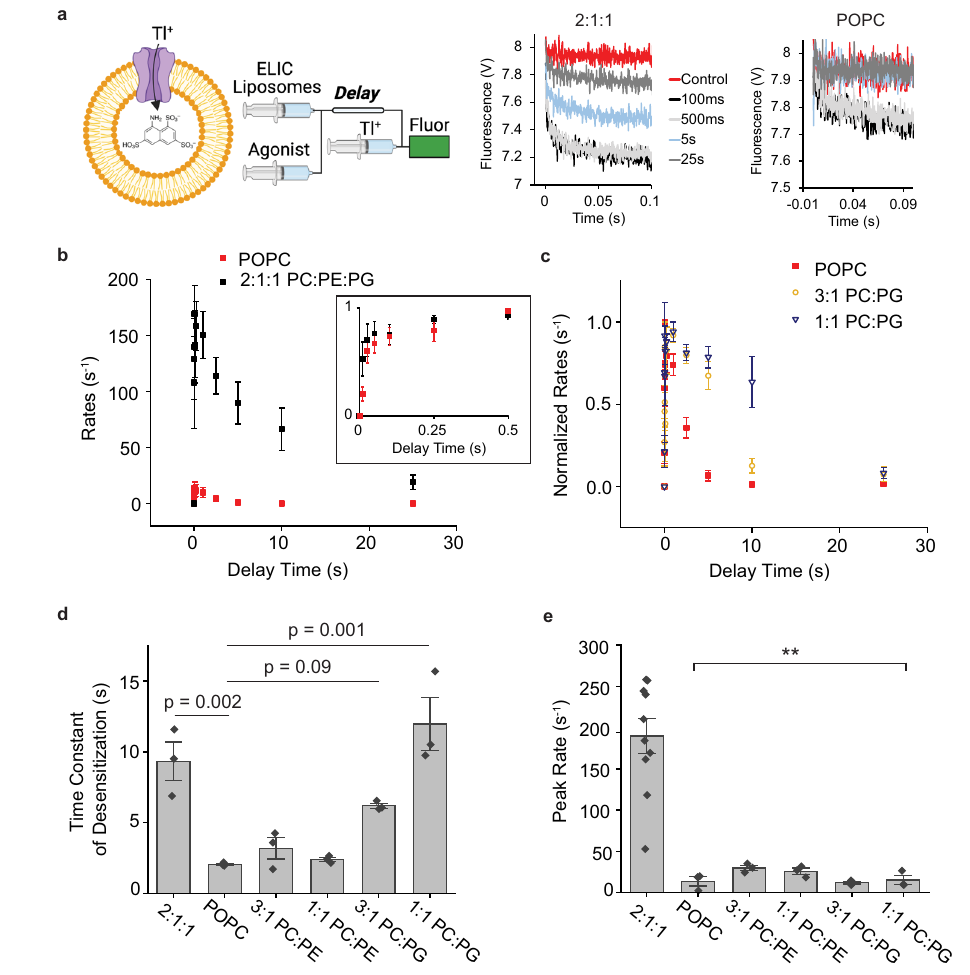
Fig. 1 | ELIC agonist responses in different lipid conditions. a Left: Schematic of the sequential mixing experiment for the fl uorescence liposomal stopped- fl ow assay (created with BioRender.com). ELIC proteoliposomes containing the fl uor- escentTl + indicator,ANTS,aremixedwithagonist(propylamine),andthenwithTl + solution after a variable delay time. Right : Representative raw fl uorescence traces; the fi rst 0.1s are fi t with a stretched exponential to determine the fl uorescence quenching rate, which relates to ELIC channel activity. The legend shows control (no agonist) and different delay times. b Tl + fl ux rates of WT ELIC in 2:1:1 POPC:- POPE:POPG (black) and POPC (red) liposomes as a function of time after mixing with 10mM propylamine ( n =3). Inset shows activation time course of normalized data.Activationwastoofasttoaccuratelydeterminetherate. c NormalizedTl + fl ux